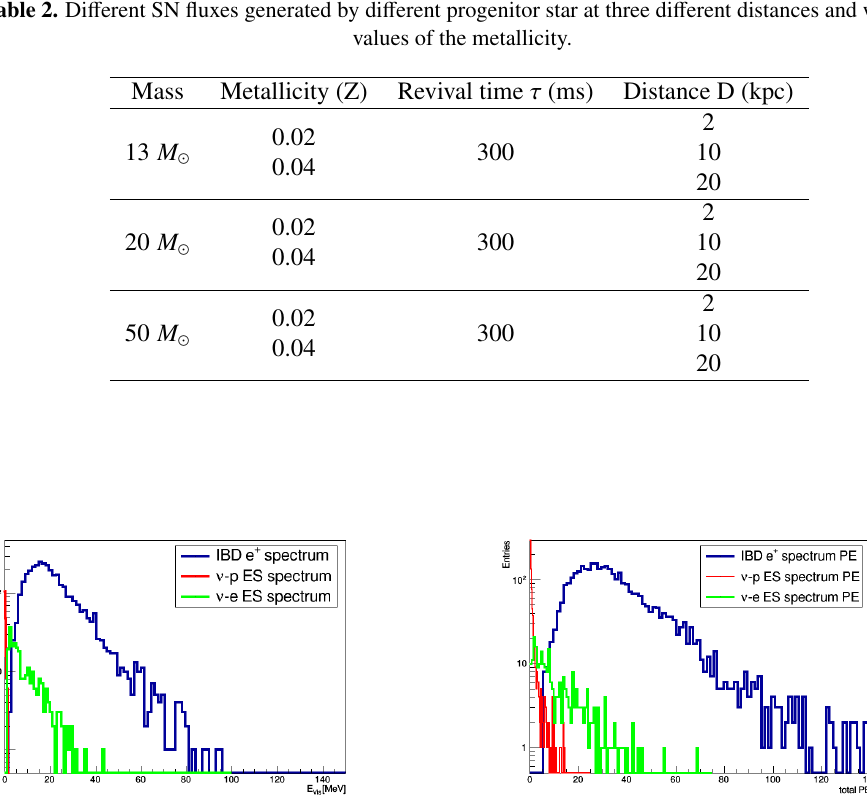
Table 2. Di ff erent SN fluxes generated by di ff erent progenitor star at three di ff erent distances and with two